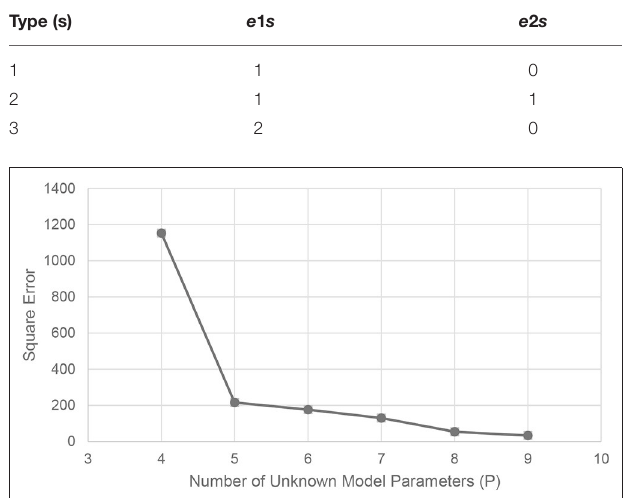
FIGURE 3 | Pareto frontier from the bi-objective optimization. Each point represents a different compartmental model.